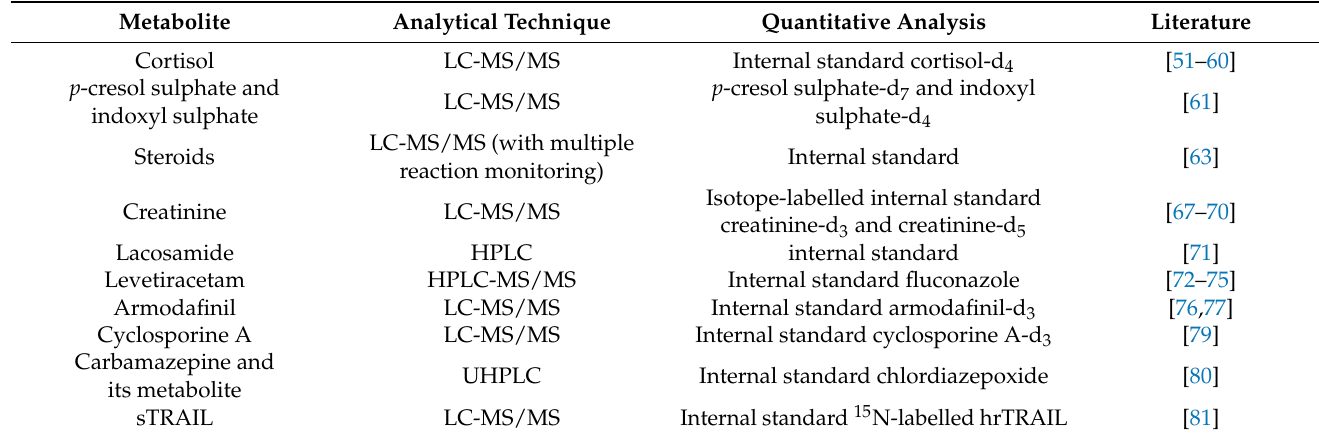
Table 1. Methods of different metabolites detection in